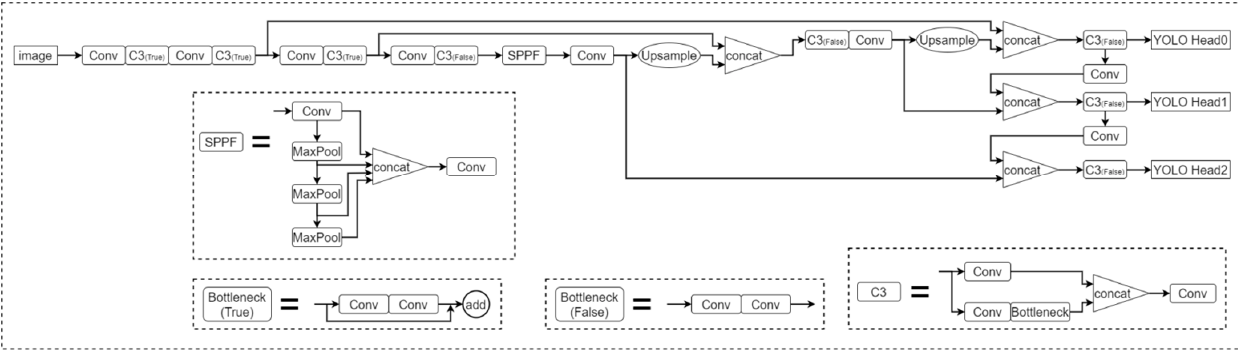
Figure 3. YOLOv5s network structure.